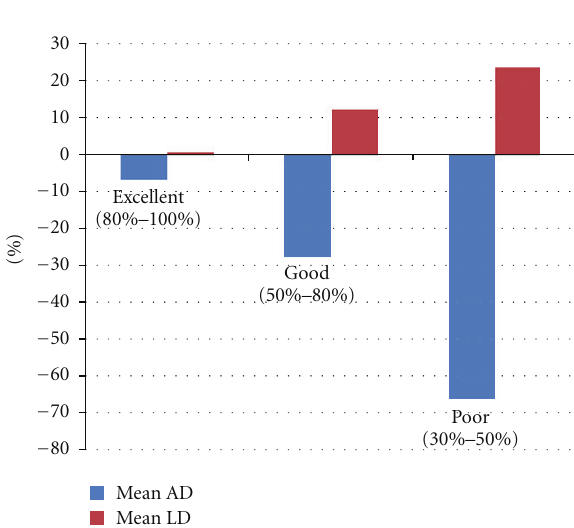
Figure 4: Mean AD and LD in the groups with excellent, good, and poor clinical